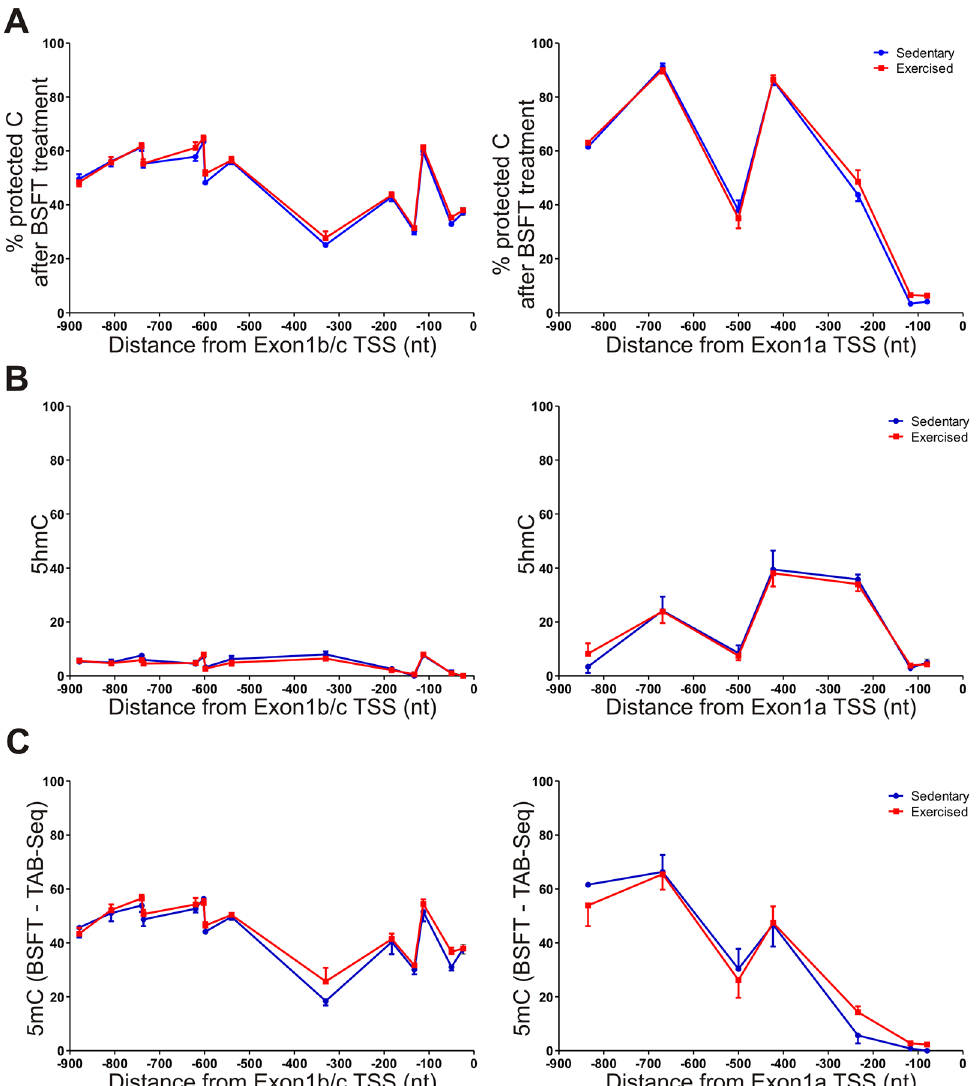
Fig 4. Measurement of 5mC and 5hmC across PGC-1 α Exon1a and Exon1b/c promoter regions. (A) Percent protected cytosines at each CpG site within the promoter region of PGC-1 α Exon1a (right) or Exon1b/c (left) after bisulfite treatment of skeletal muscle DNA. (B) Percent protected cytosines after TAB-Seq, showing the level of 5hmC at each CpG site. (C) The level of 5mC is shown at each CpG site across the PGC-1 α